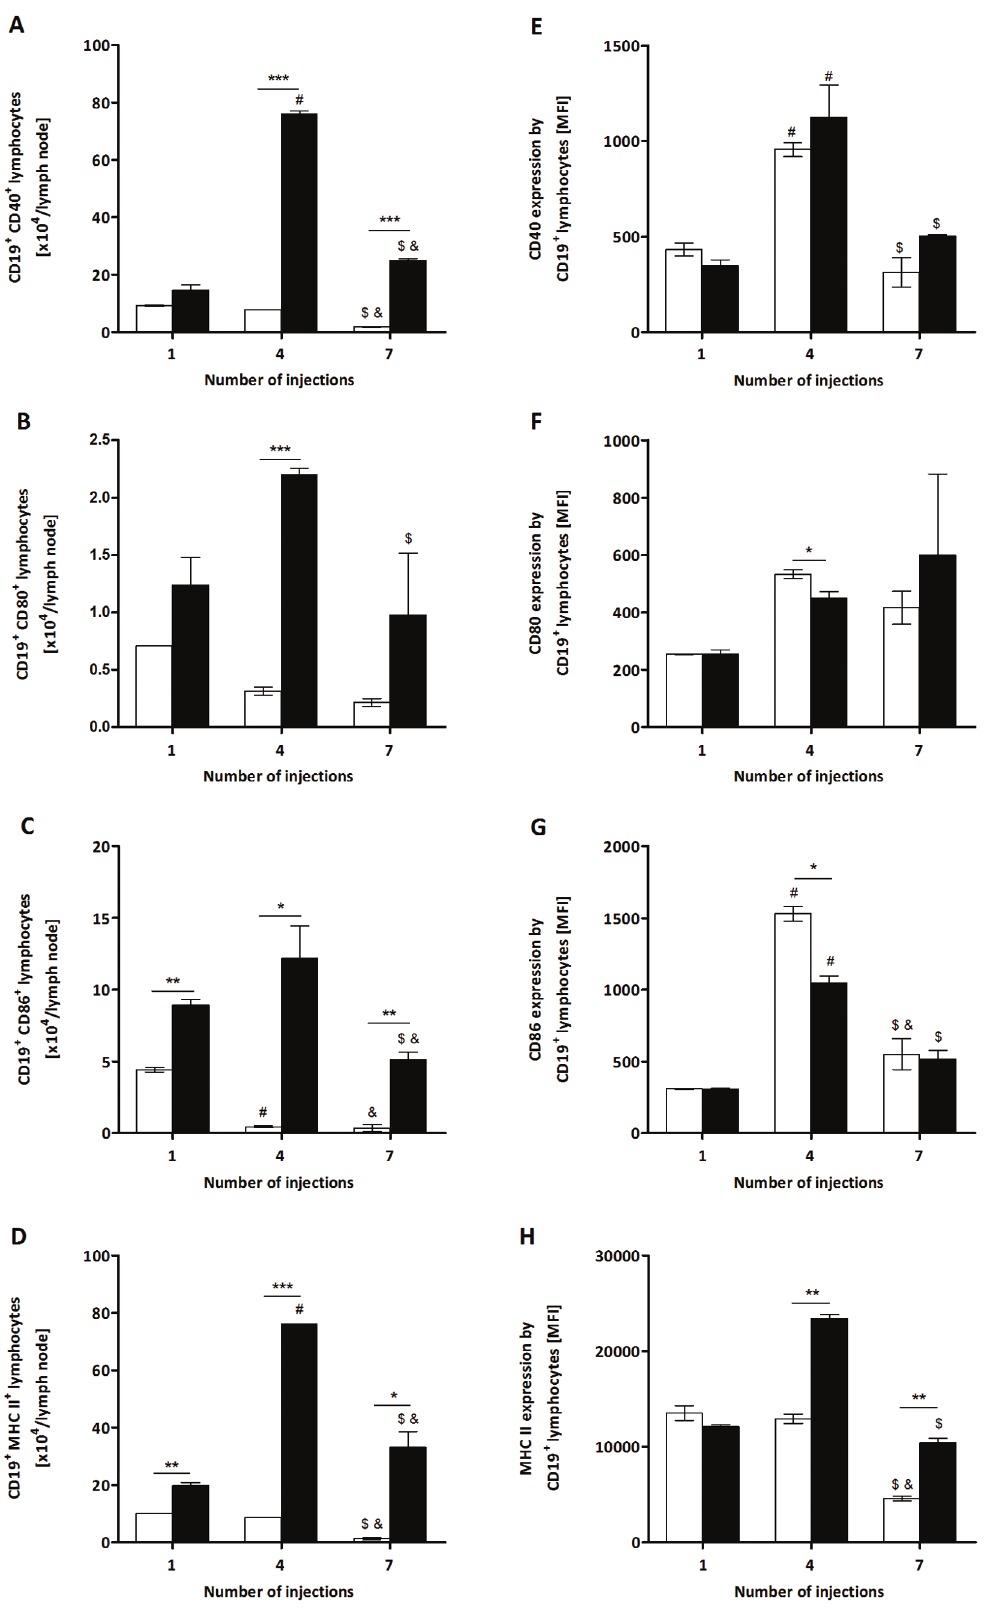
Figure 3. Total number of CD40 + , CD80 + , CD86 + and MHC II + B cells and their expression from P . semirufa group. BALB/c mice were repeatedly injected with 50 m L of pyrogen-free saline ( % ) or 10 m g (protein) of the extract ( & ) in the footpad and, after the 1 st , 4 th and 7 th inoculations, the popliteal lymph nodes were collected and processed for flow cytometry analysis. Total number of (A) CD19 + CD40 + B lymphocytes, PLOS ONE |